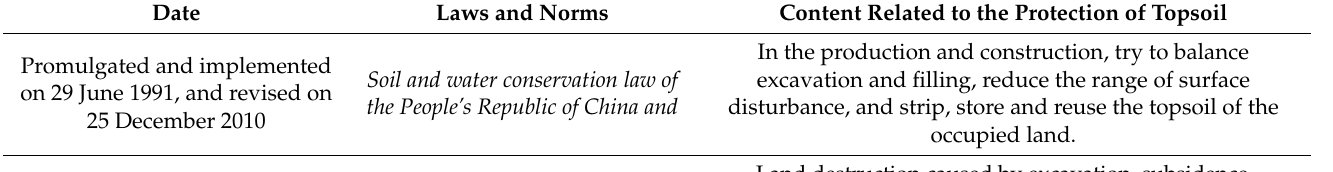
Table 3. Specific provision on topsoil protection and utilization of laws and norms in production and construction